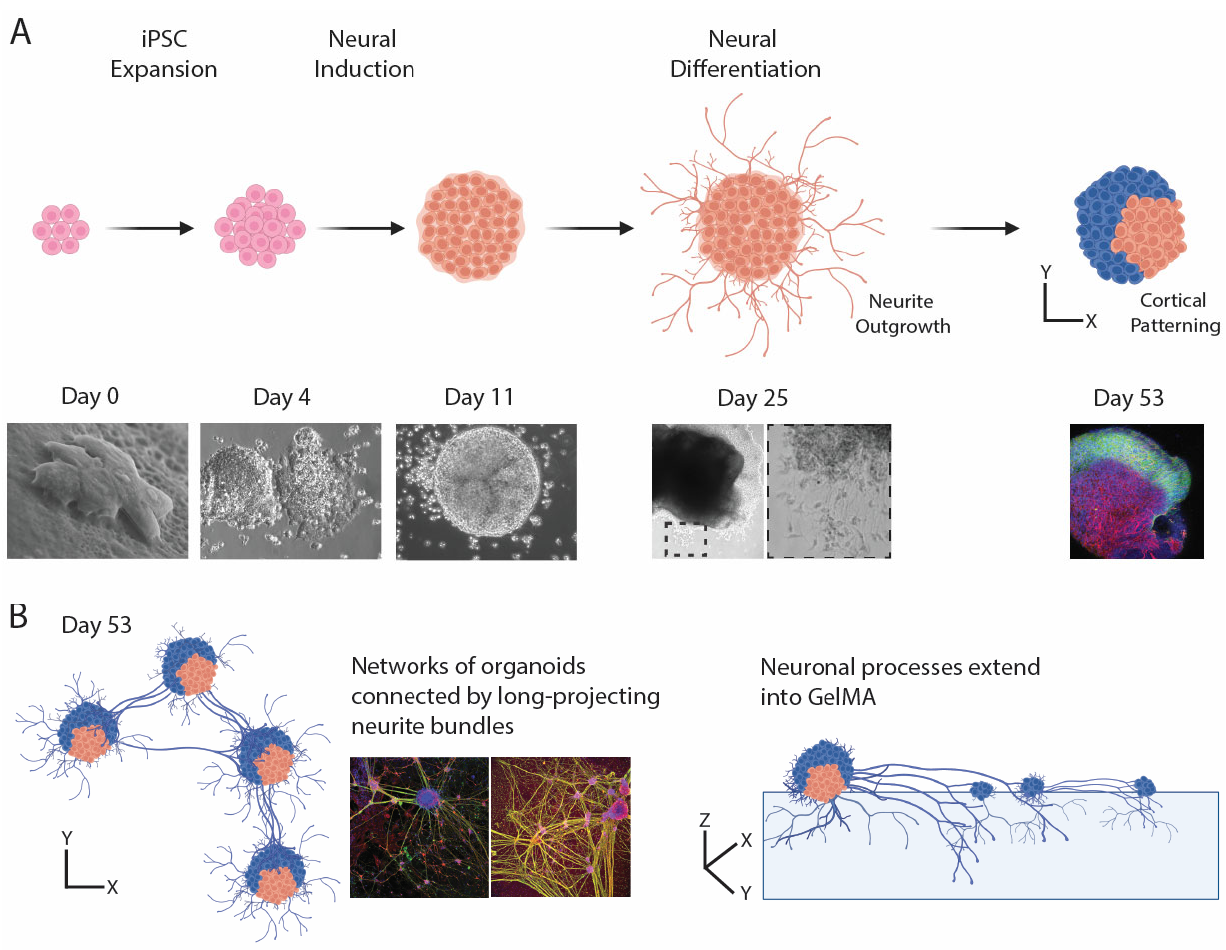
Figure 1. GelMa-based iPSC differentiation to human brain organoids. ( A ): Timeline illustrating the major stages for producing brain organoids from iPSCs on GelMA, including iPSC expansion, neural induction, and neural differentiation. ( B ): Networks of organoids can be propagated on GelMA hydrogel, connected via long-projecting neurite bundles, with neurite processes extending into the